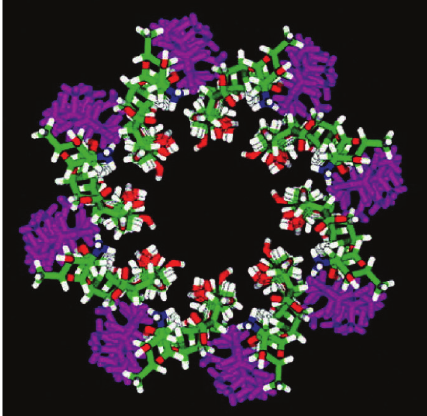
Figure 4: 3D model of pore formed by amphotericin B into lipid bilayer of the fungal plasma membrane, adapted from Baginski et al. [29]. Amphotericin B: white (H), green (C), red (O), and blue (N); ergosterol: